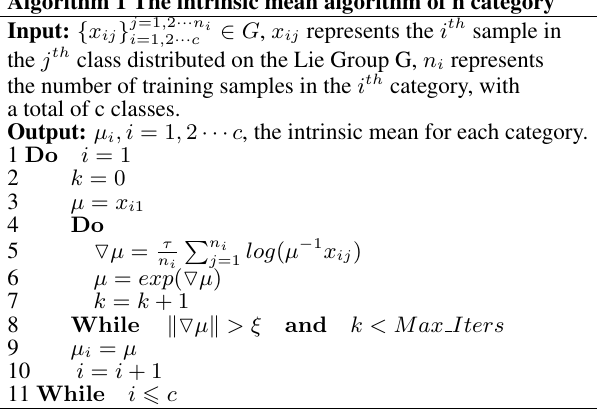
Algorithm 1 The intrinsic mean algorithm of n